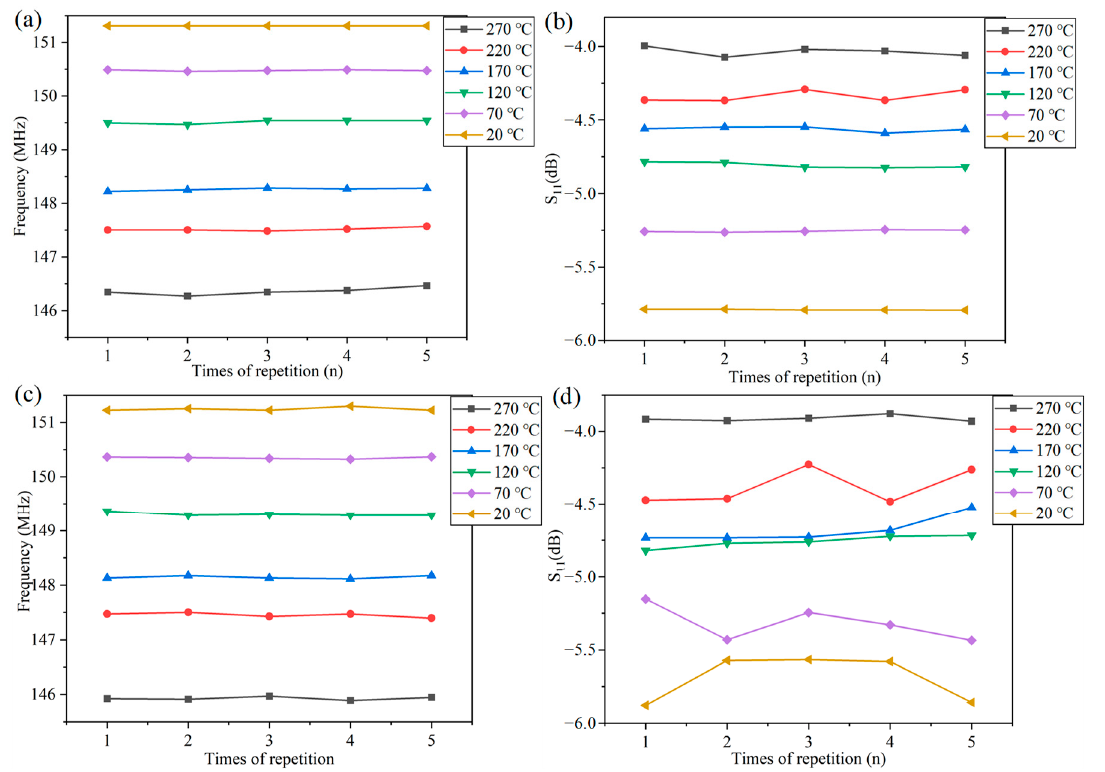
Figure 8. ( a ) Stability of frequency with temperature at 0 rpm; ( b ) stability of S 11 with temperature at 0 rpm; ( c ) stability of frequency with temperature at 60 rpm; ( d ) stability of S 11 with temperature at 60 rpm.